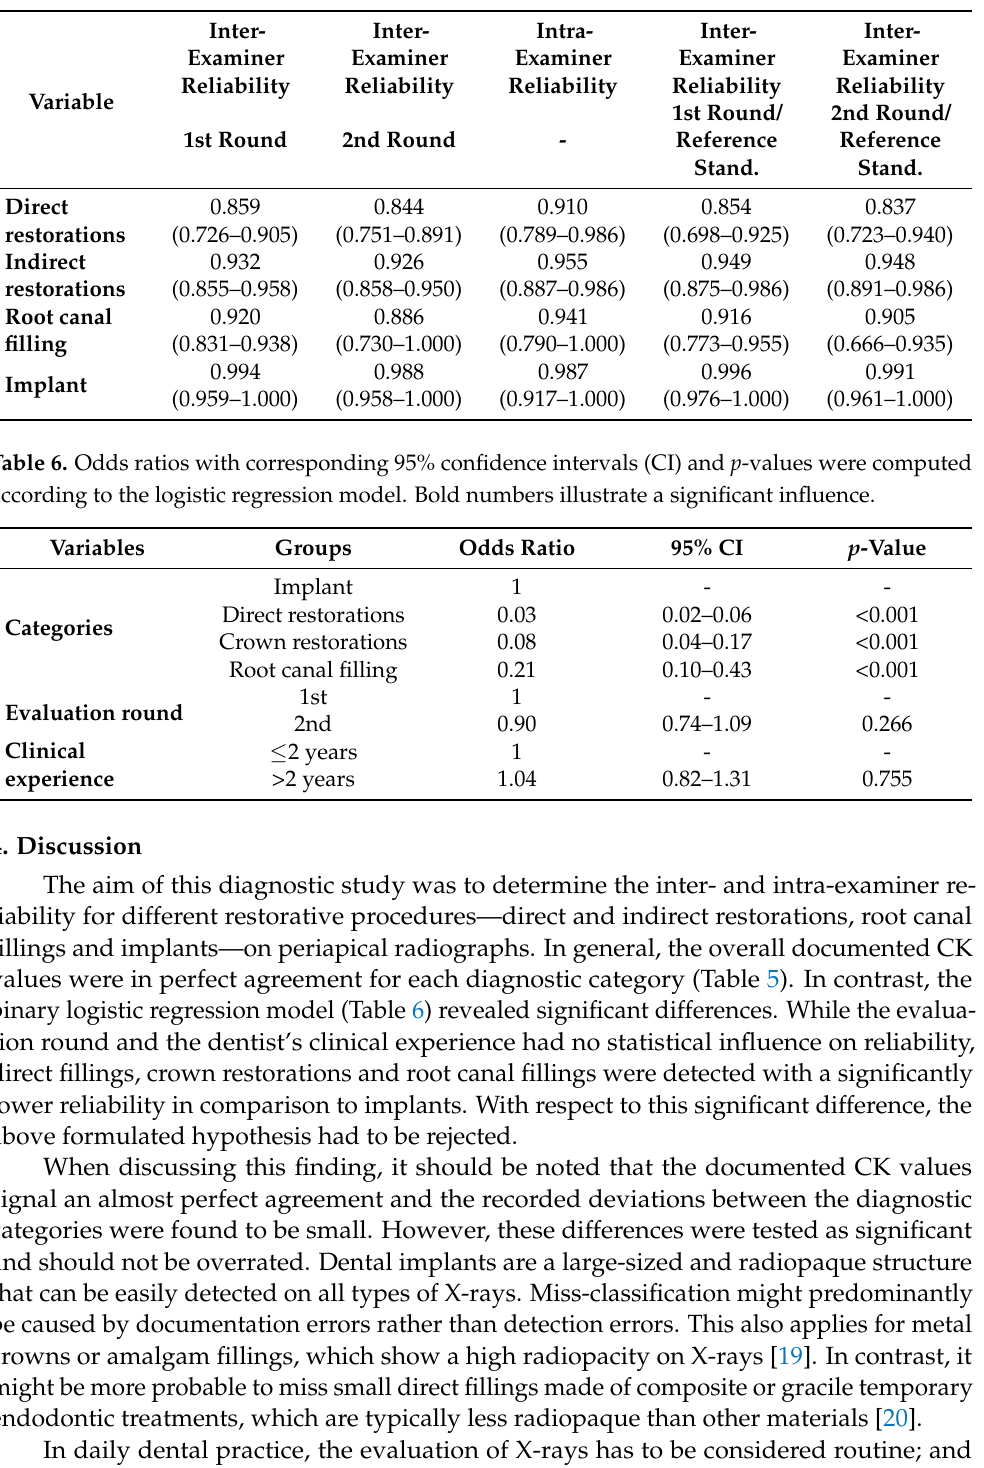
Table 5. Mean CK values of the inter- and intra-examiner reliability for all evaluated categories.